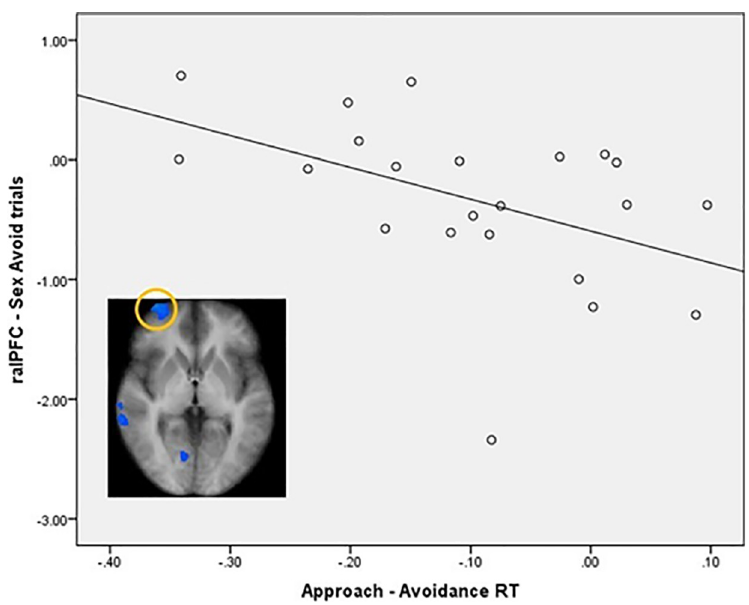
Fig 5. Brain activity correlates with the behavioral output in the Approach–Avoidance task. The activity of the right anterolateral prefrontal cortex during Sex Avoid trials negatively correlated with the Approach-Avoidance index (faster sexual avoidance and-or slower sexual approach reaction